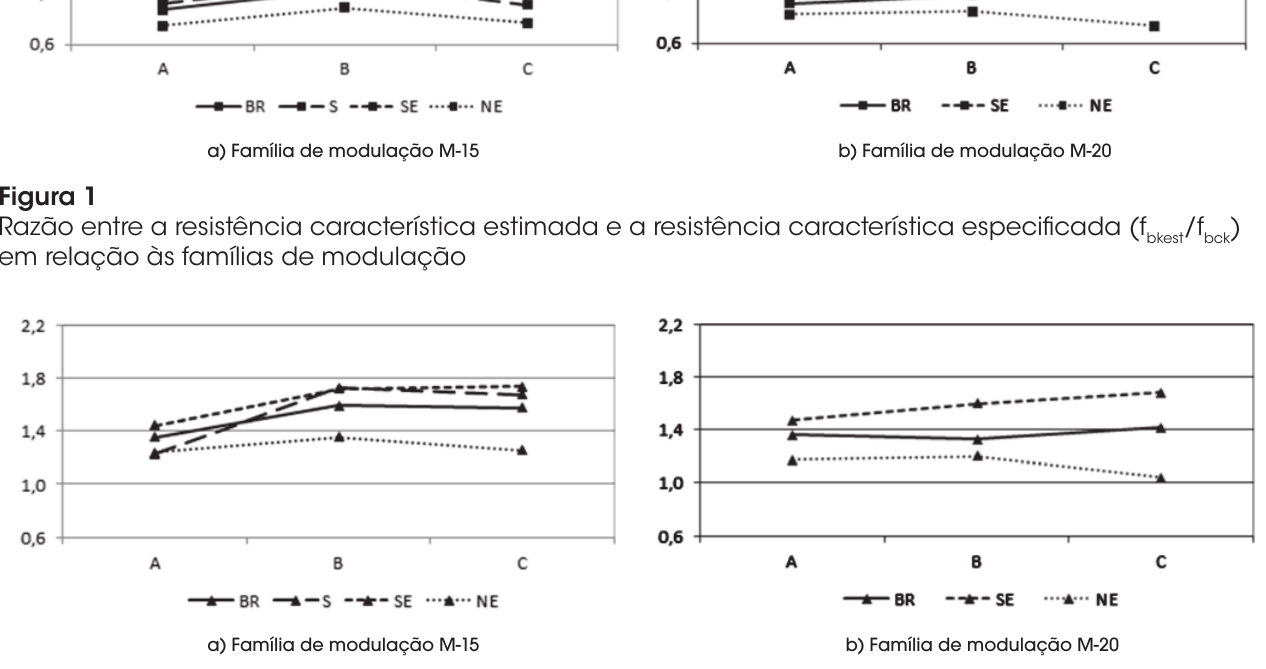
/f ) em relação às bm bck